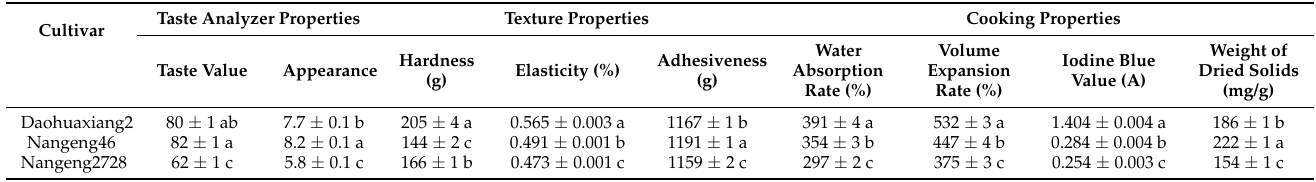
Table 1. Differences of cooked rice properties among different japonica